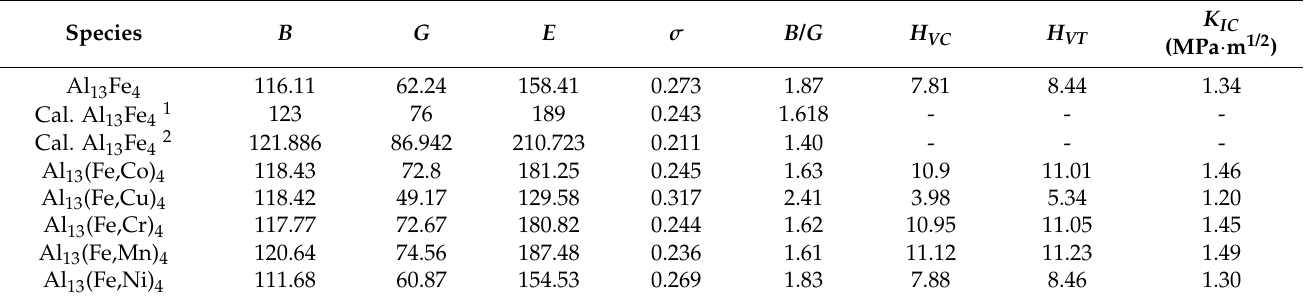
Table 5. Bulk modulus, shear modulus, Young’s modulus, Poisson’s ratio, B / G , and intrinsic hard- ness of Al 13 (Fe,M) 4 phases with different elements doping, and the unit is GPa.